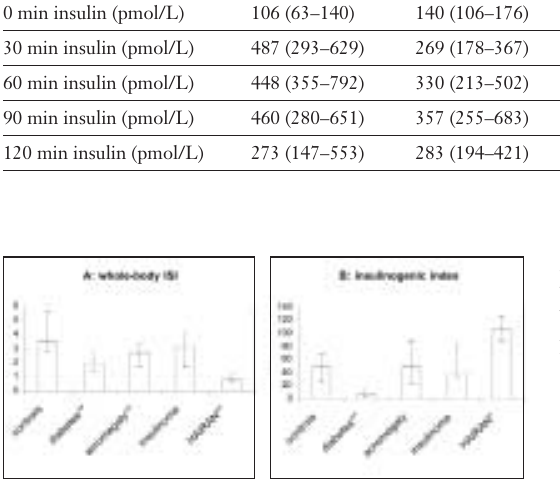
Demographic charac- teristics of patients and results of the OGTT. Demographic charac- teristics and data from the OGTT in 32 healthy controls, 65 type 2 diabetic patients, 15 patients with acromegaly, 10 insulinoma pa- tients and 4 patients with HAIRAN syn- drome. Data are shown as median and quartiles (Q 25 –Q 75 ). PG = plasma glucose.